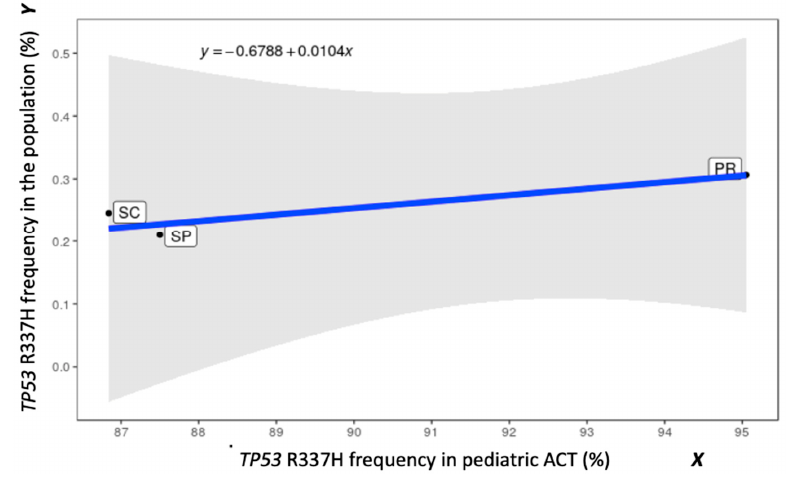
Figure 2. The R337H frequencies (population versus ACT) and the obtained linear regression (LR) based on the overall averages for each state (SP, Paraná state (PR), and Santa Catarina (SC)). The blue straight line was obtained by simple LR using the method of least squares weighted by the number of individuals tested in each state, assuming equal weights for the considered variables. The shaded area represents the 95% confidence interval of the line assuming the normality of the errors.